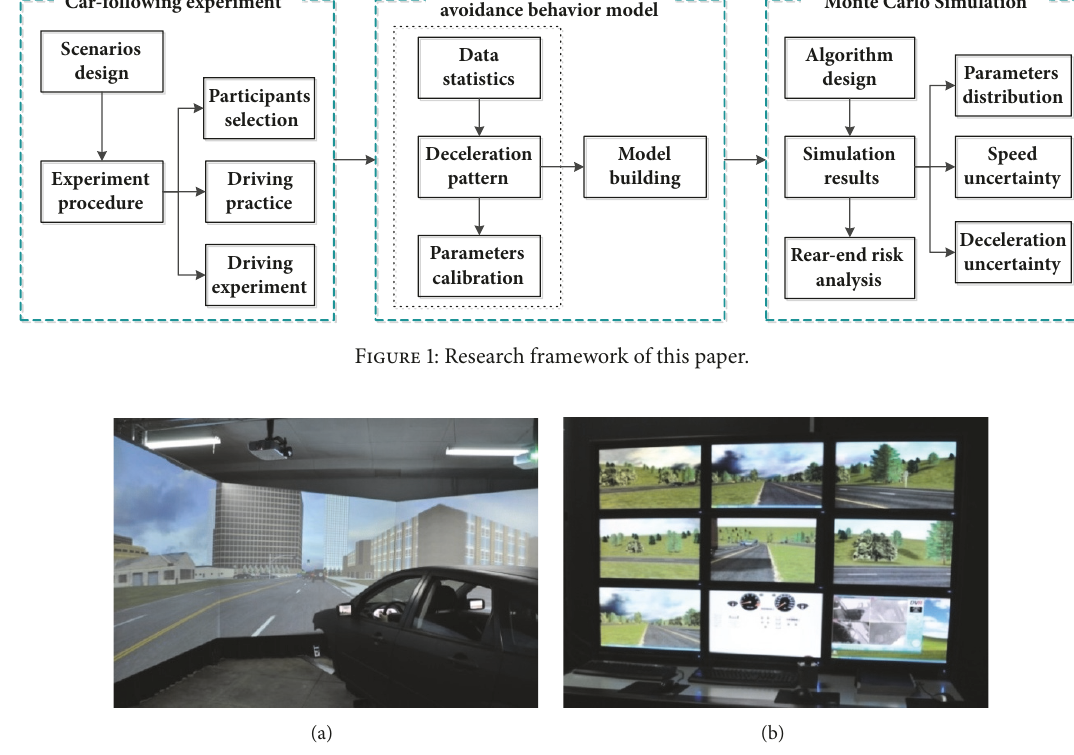
Figure 2: Illustration of the driving simulator system: (a) realistic cabin of Ford Focus and (b) operation